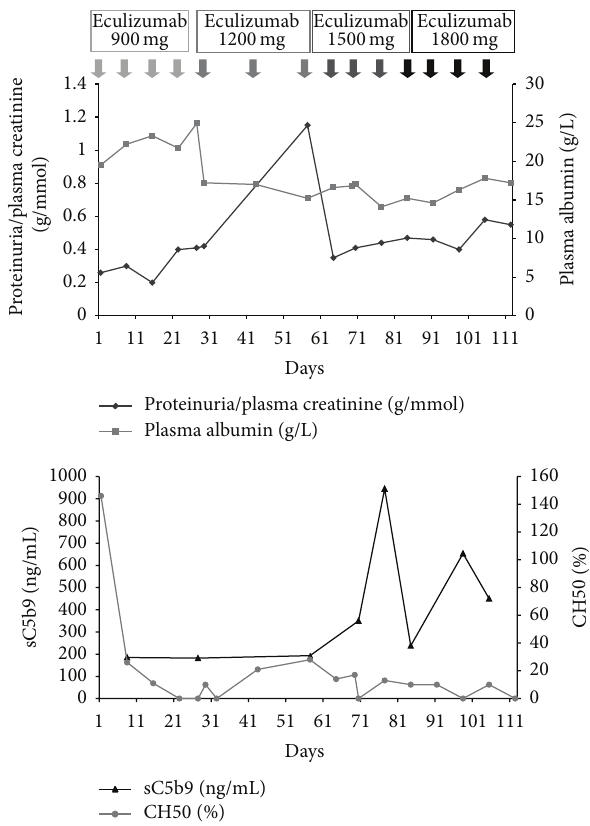
Figure 2: Response to eculizumab therapy in dense deposit